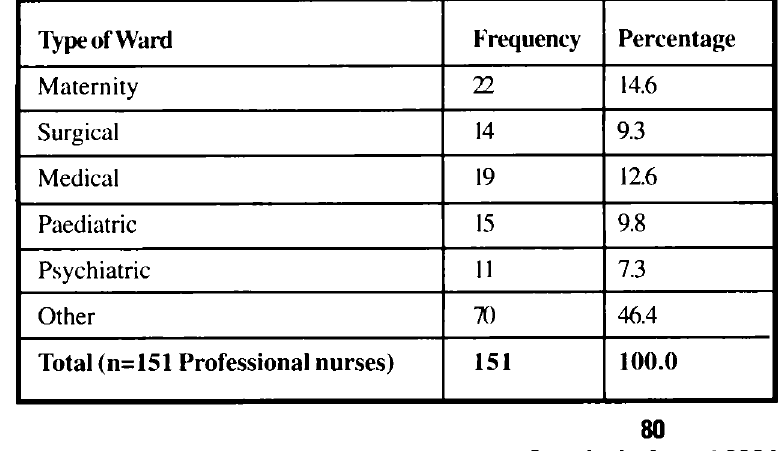
Table 4: Distribution of types of wards: Professional nurses